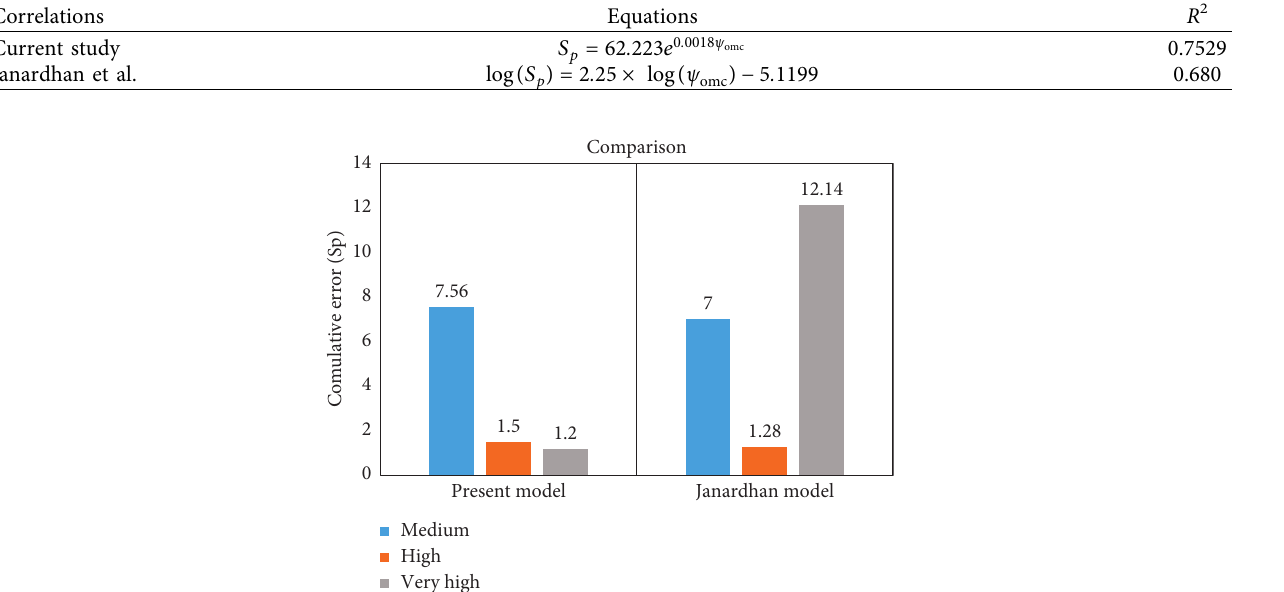
Figure 10: Comparison of the cumulative errors that occurred in the two